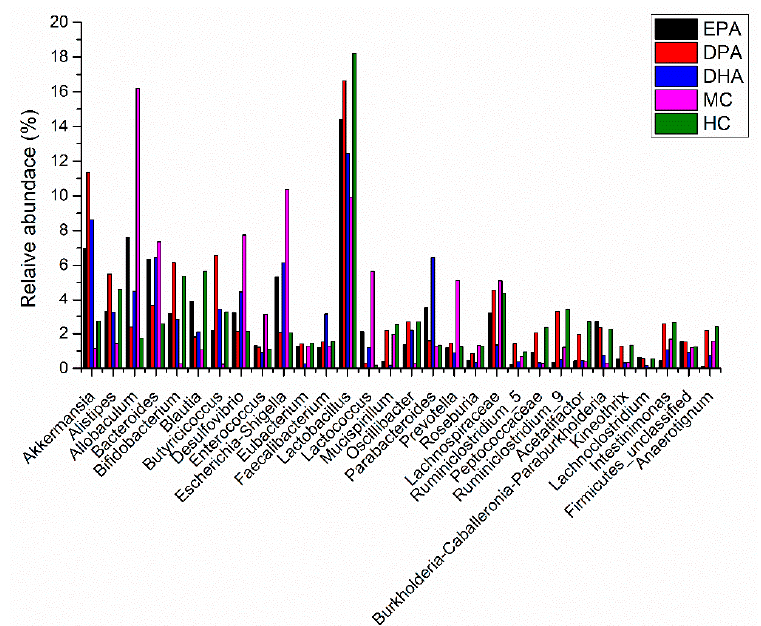
Figure 4. The abundance changes of the gut microbiota in the different groups at genera level. Note: EPA, DPA, DHA, MC, HC represent EPA group, DPA group, DHA group, model control group, health control group, respectively.